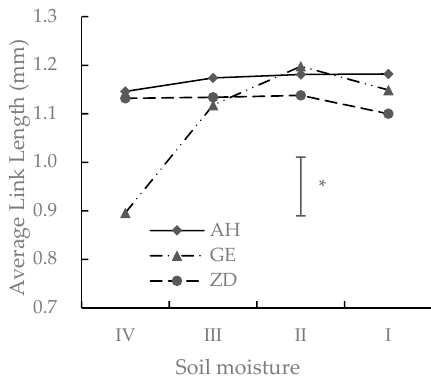
Figure 4. Interaction on link average length between cultivars (AH, GE and ZD) and soil moisture (See Figure 2 for soil moisture abbreviations). * p < 0.05. Table 3. Mean average link length (ALL; mm) under various soil moisture (See Table 1 for soil moisture abbreviations) and cultivar (AH, GE and ZD) treatments. * p < 0.05; ns-no